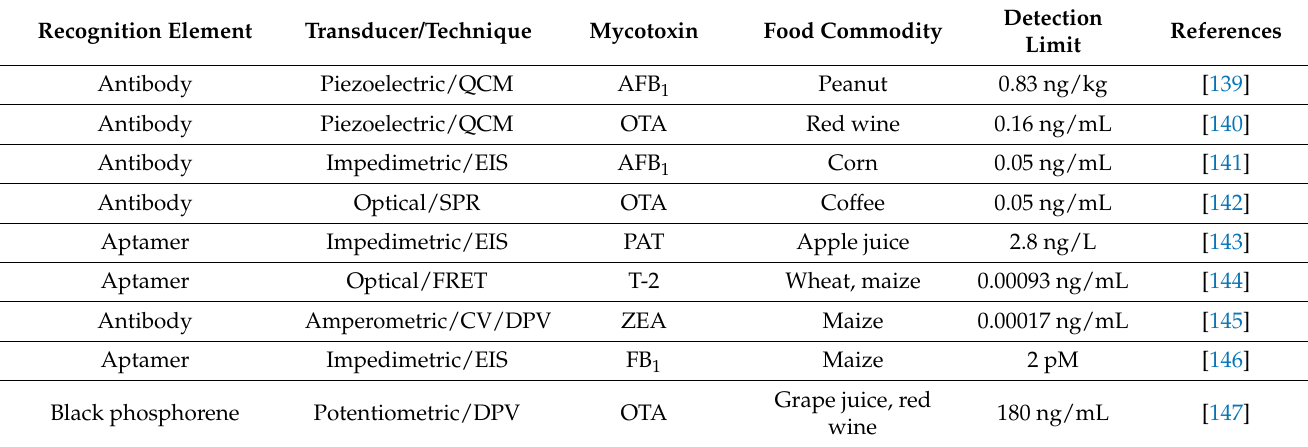
Table 5. Examples of biosensors used in different mycotoxin